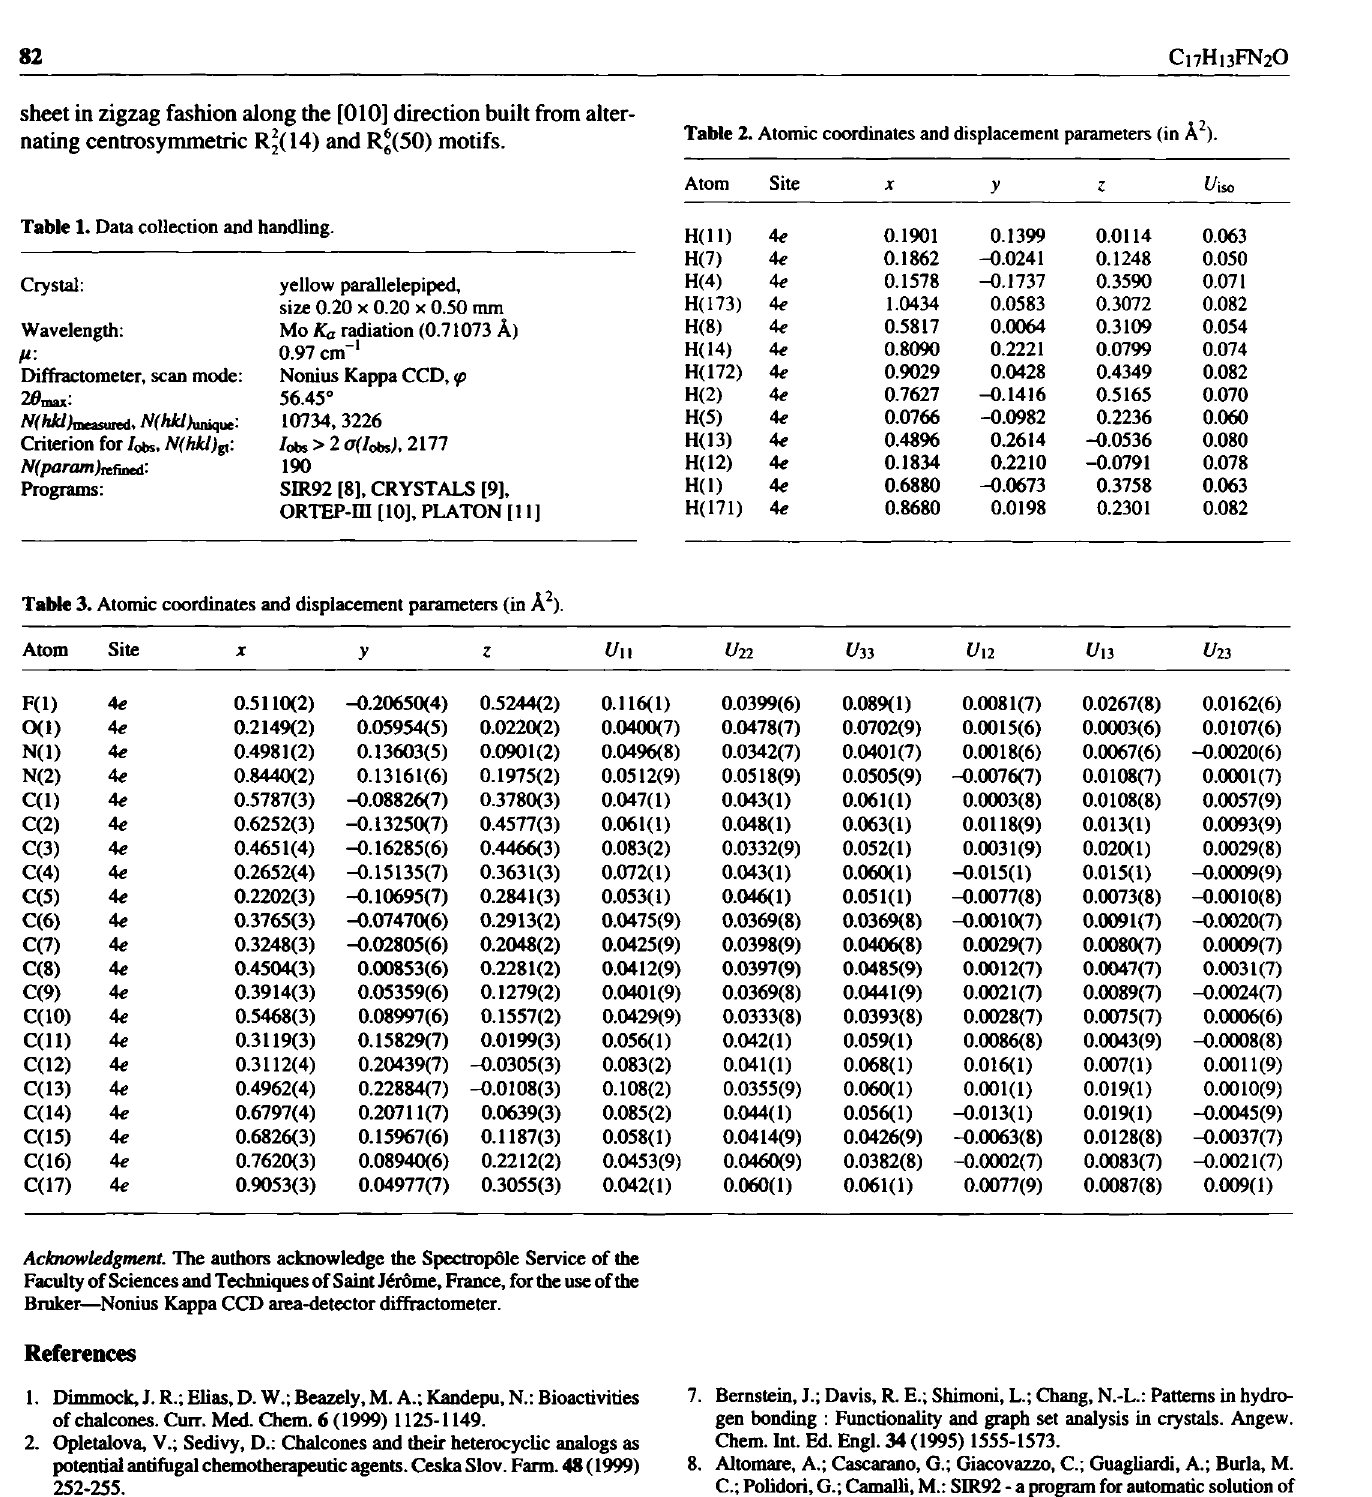
Table 2. Atomic coordinates and displacement parameters (in À 2 ).